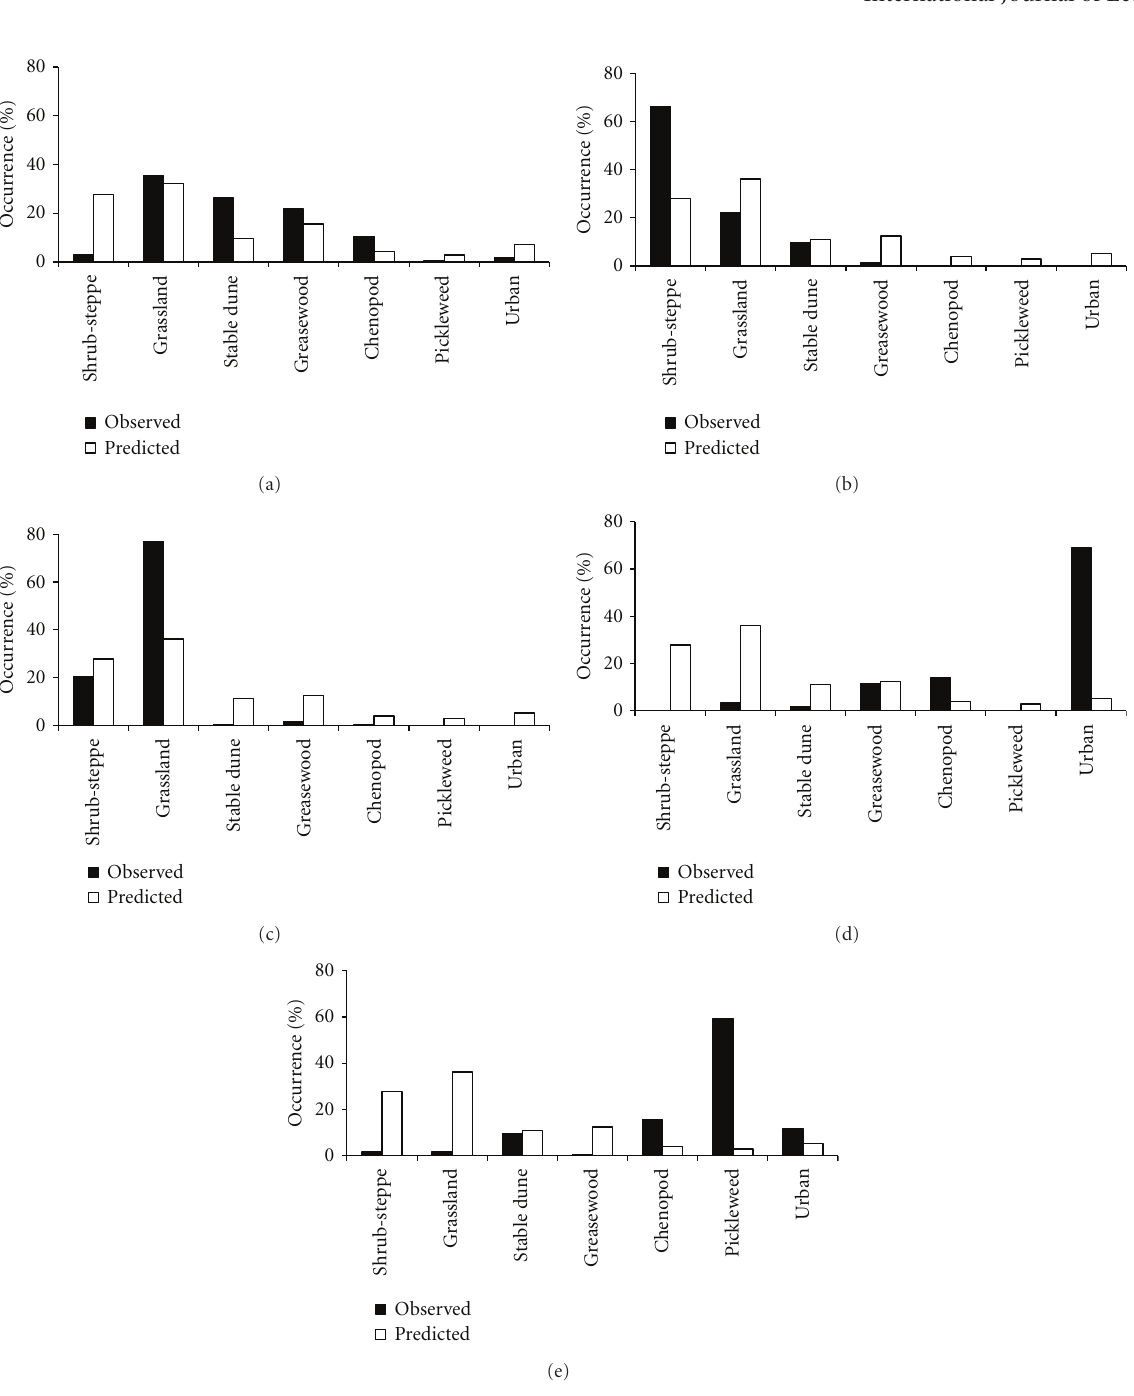
Figure 4: Observed and predicted canid distributions for (a) coyotes, (b) mountain kit foxes, (c) grassland kit foxes, (d) city kit foxes, and (e) poverty kit foxes, Dugway Proving Ground, Utah,